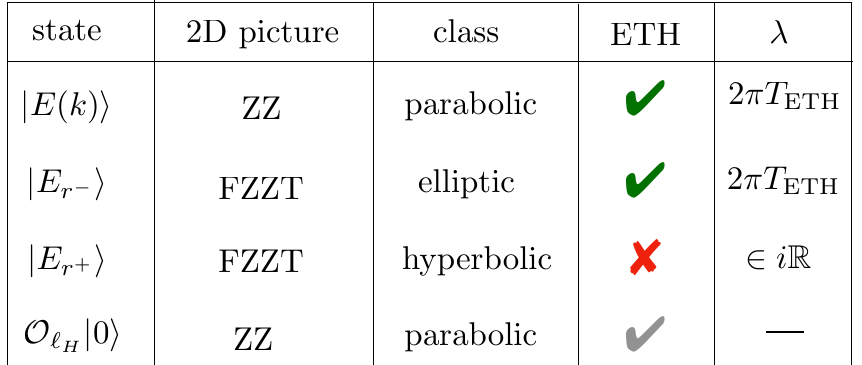
Figure 8. Panoramic summary of the pure states studied in this paper and their thermal properties. We see that in all cases where the system behaves thermally it satis(cid:12)es maximal extended ETH (we did not compute the Lyapunov exponent in the last line of this table). The states p 2. The grey tick mark indicates that the states in question show coherent FZZT states for r > < only a weak form of